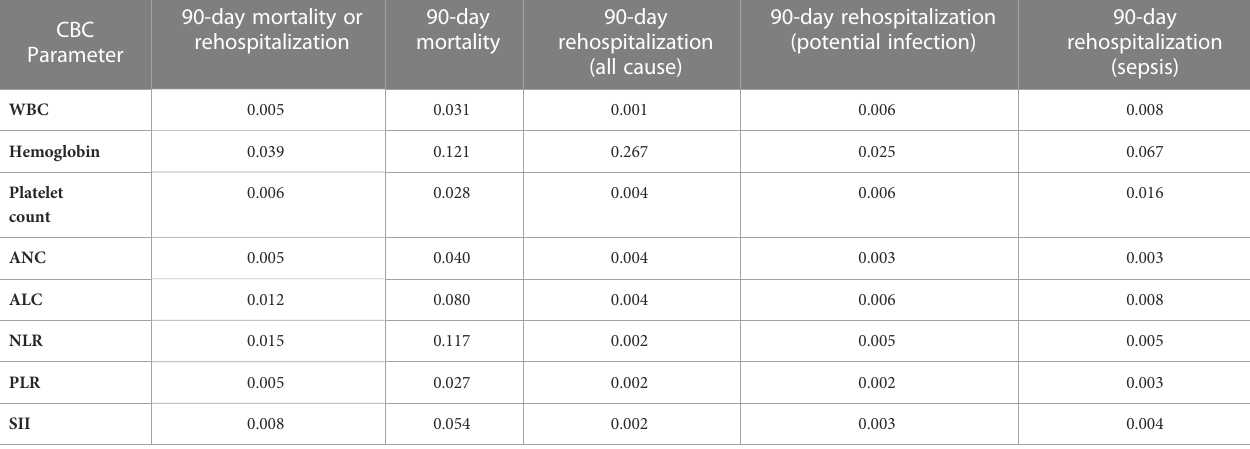
TABLE 2 Prognostic separation (R 2 D ) of Kaplan-Meier failure plots CBCD parameters by outcome.